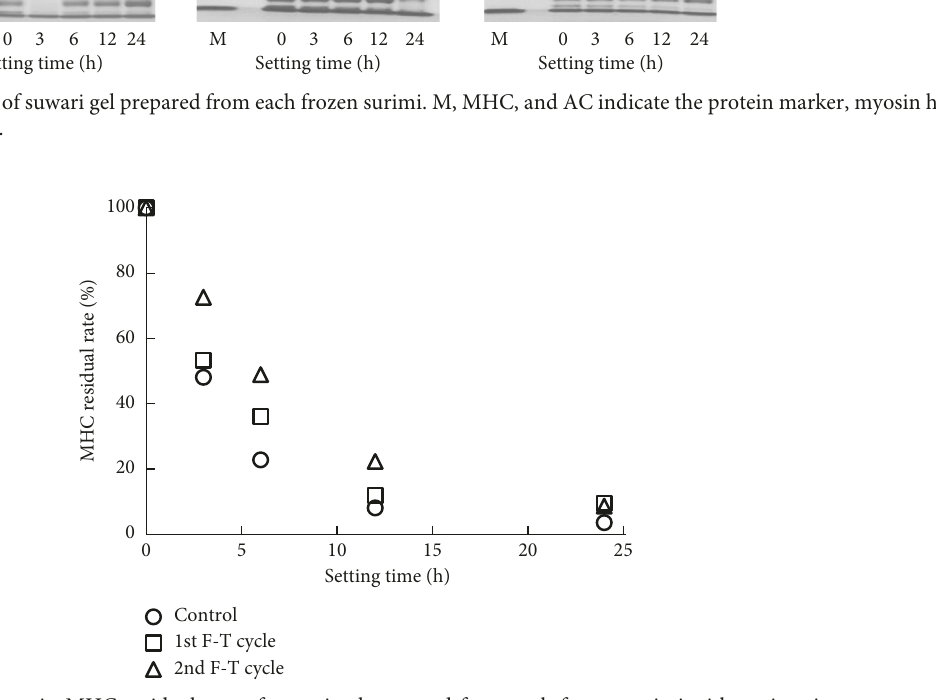
Figure 7: Changes in MHC residual rate of suwari gel prepared from each frozen surimi with setting time.